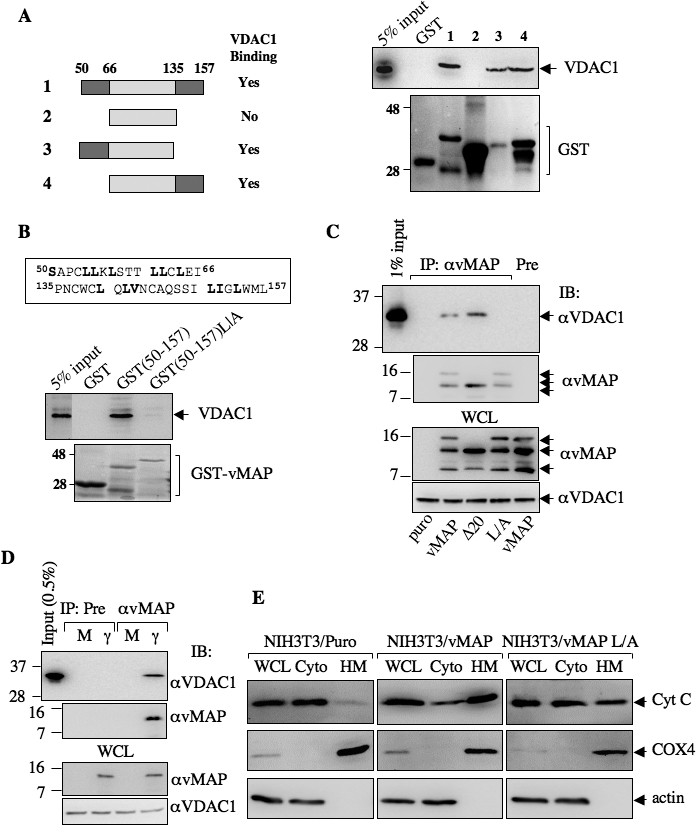
vMAP Interaction with VDAC1 Inhibits Cytochrome c Release(A) vMAP contains two VDAC1-interacting regions (dark grey boxes). The left panel shows the schematic diagram of vMAP interaction with VDAC1. (Right panel) GST fusions containing various vMAP sequences were expressed and purified from E. coli. 293T cells were lysed in CHAPS buffer and subjected to in vitro GST pull-down, followed by immunoblotting with anti-VDAC antibody. The bottom panel shows the Coomassie blue staining of GST fusion proteins. Lanes 1–4 correspond to the GST fusions shown by the left diagram.(B) The LLxL repeat sequences of vMAP are required for VDAC1 interaction. (Top box) The boxed sequences are the two LLxL repeats of vMAP. GST or GST fusion proteins were used to bind to VDAC1 from 293T cell lysates in CHAPS buffer as described in (A). Protein precipitates were analyzed by immunoblotting with anti-VDAC antibody (top blot) and Coomassie blue staining of GST fusion proteins (bottom blot).(C) vMAP interacts with VDAC1 in stable cell lines. NIH3T3 cells stably expressing vector, vMAP, or its mutants were used for immunoprecipitation with anti-vMAP serum or pre-immune (Pre) serum, followed by immunoblotting with anti-VDAC antibody (top panel) or anti-vMAP serum (middle panel). WCLs were analyzed by immunoblotting with anti-vMAP serum and anti-VDAC antibody (bottom two panels).(D) vMAP interacts with VDAC1 in γHV-68-infected cells. WCLs of mock (M)- or γHV-68 (γ)-infected (MOI = 1) cells were precipitated with anti-vMAP or preimmune serum, followed by immunoblotting with anti-VDAC antibody (top panel) or anti-vMAP serum (middle panel). WCLs were analyzed by immunoblotting with anti-vMAP serum and anti-VDAC antibody (bottom two panels).(E) vMAP inhibits cytochrome c release upon ST treatment. NIH3T3/puro, NIH3T3/vMAP, or NIH3T3/vMAP L/A cells were treated with ST (1 μM) for 4 h and WCLs were sequentially centrifuged to obtain cytosolic (Cyto) and mitochondrion-enriched heavy membrane (HM) fractions. Polypeptides (20 μg) from each fraction were analyzed by immunoblotting with antibodies to cytochrome c (Cyt C), COX4, and actin.